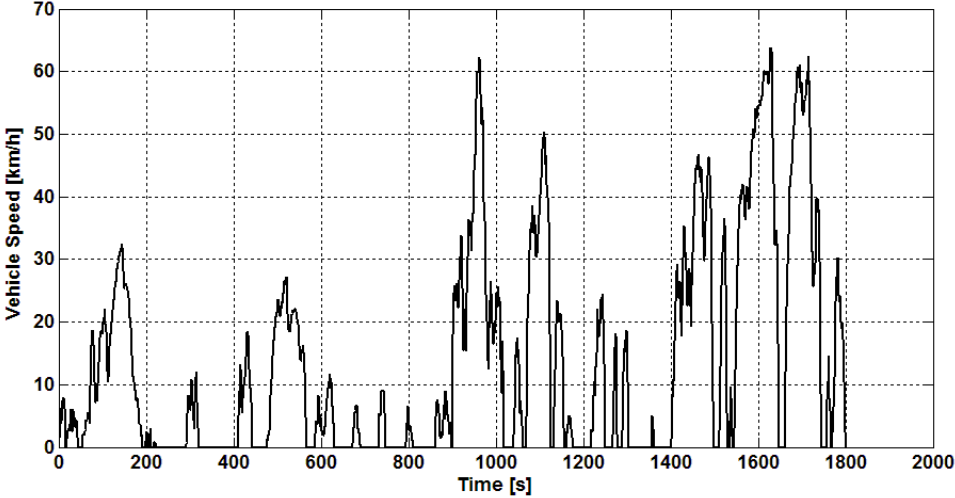
Figure 12. Beijing typical citybus driving cycle. Table 2. The statistics of the Beijing typical citybus driving cycle.